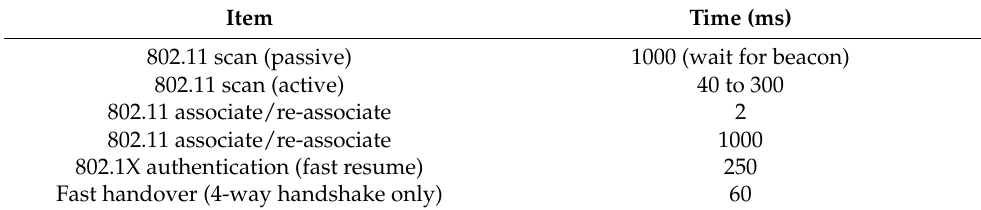
Table 1. Layer 2 handover delay [15].